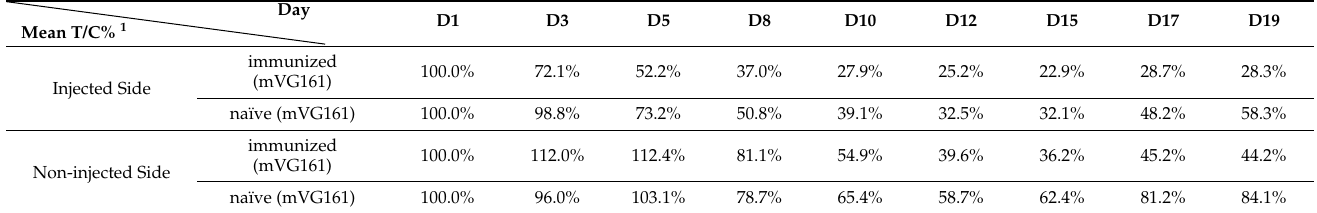
Table 2. Summary of mean ratio of T/C in bilateral-tumor